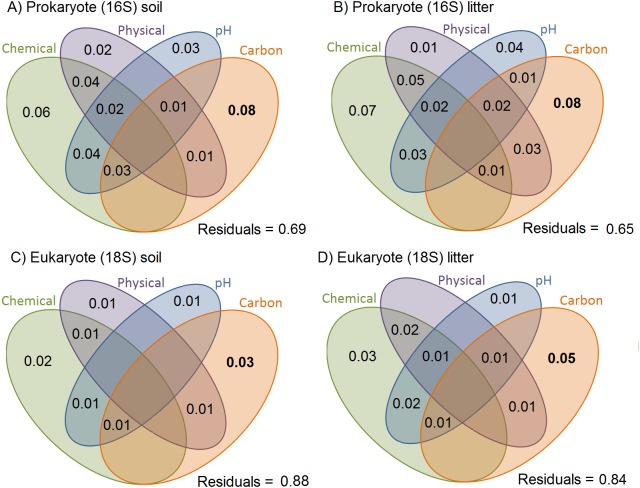
Variation in OTU community composition in Amazonian soil samples explained by soil characteristics.Results of the variance partition analysis based on Jaccard dissimilarity distance-based analysis. Small but significant proportions of soil and litter communities vary with soil variables, and a small but significant proportion shows variation shared by soil variables. All values represent the proportion of variation explained by the factor/interaction. Chemical variables are shown in green (based on the first PCA of chemical variables, see Table S3 for details), physical variables in purple (based on first PCA axis of soil texture, see Table S2 for details), pH in blue, and carbon content in orange. The prokaryote communities are more structured by soil characteristics than are the eukaryote ones. Inside each taxonomic group, the litter communities are more structured by soil characteristics than are the soil communities.